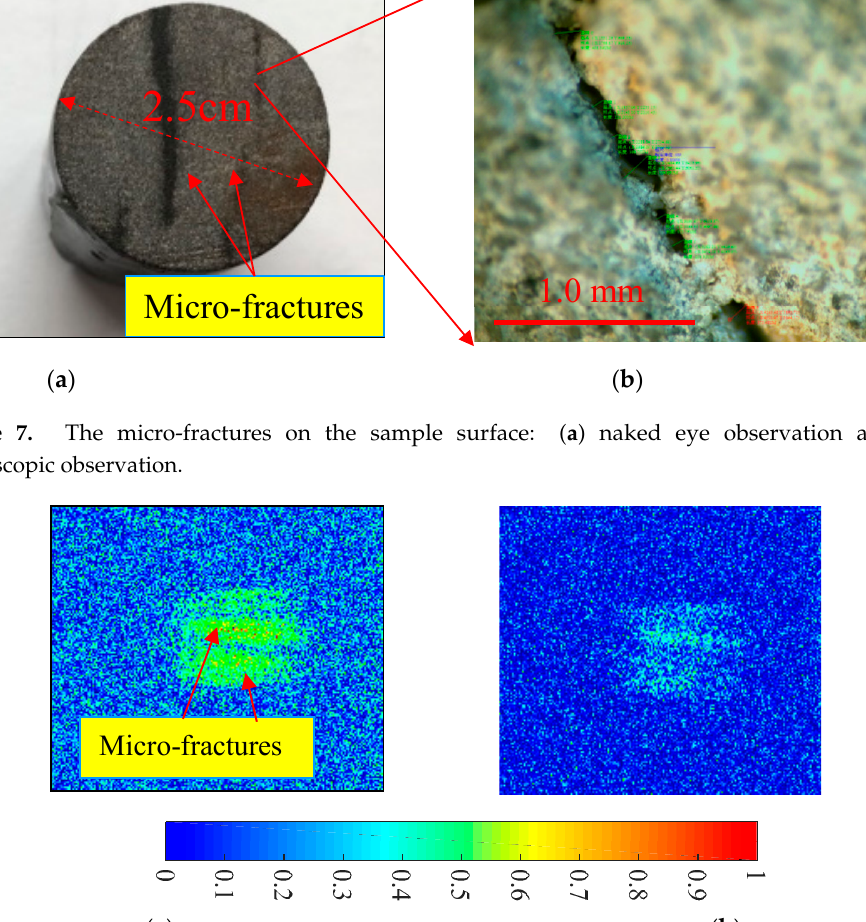
( b ) Figure 9. The T 2 spectra vs soaking time in UC7-2 and LC7-2 samples: ( a ) UC7-2 and ( b ) LC7-2. Figure 9 shows the relationship between T 2 spectra and soaking time. The distribution range of fractures corresponds to >10 ms, which involves largish pores and large pores. The sample LC7-2 contained a small amount of micro-fractures that were speculated by T 2 spectra. The samples of UC7-2 and LC7-2 were embedded by micro-fractures and characterized by different oil migration features. The amplitude decline velocity of largish pores and large pores was larger than that of micro-pores. Compared with the micro-pores, the micro-fractures were the dominant channels for oil migration. According to the NMR imaging shown in Figure 8, a large amount of oil exited in the micro-fractures. As the soaking time increased, the water preferentially entered the natural micro-fractures, expelling the oil in the micro-fractures. Subsequently, the oil in the small pores was slowly expelled. When the soaking time was 500 h, the imbibition oil recovery of sample UC7-2 and LC7-2 were about 36.6% and 34.1% respectively. Sample UC7-2 had more micro-fractures that were beneficial to imbibition oil recovery to some extent. Figure 10 presents the oil recovery in different diameter pores of UC7-2 and LC7-2. In the UC7-2, the oil recovery of micro-pores, small pores, largish pores and large pores was 32.1, 23.5, 55.2 and 82.7% respectively. In the LC7-2, the oil recovery of micro-pores, small pores, largish pores and large pores was 45.6, 1.5, 30.5 and 66.8% respectively. The oil recovery of large pores was much larger than that of micro-pores. Water preferentially enters the micro-fractures to expel the oil. The micro-pores oil recovery of UC7-2 and LC7-2 was much smaller than that of UC7-1 and LC7-1. Therefore, the existence of micro-fractures may hinder oil migration from micro-pores into large pores. This results in higher residual oil saturation in the micro-pores.